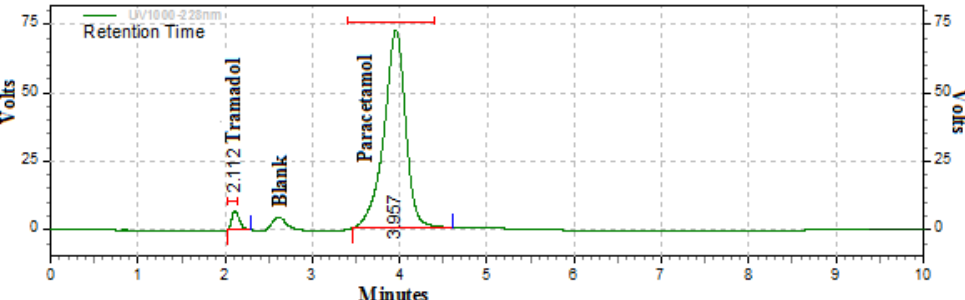
Figure 2. Typical chromatogram obtained from tramadol and paracetamol